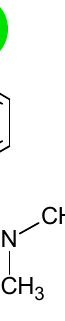
Figure 5. Structure of Amberlyst ® A21.